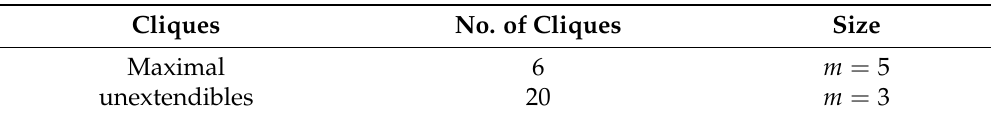
Table 1. Total number of complete sets of MUBs (maximal cliques) and the WUS (unextendible cliques) existing in 2